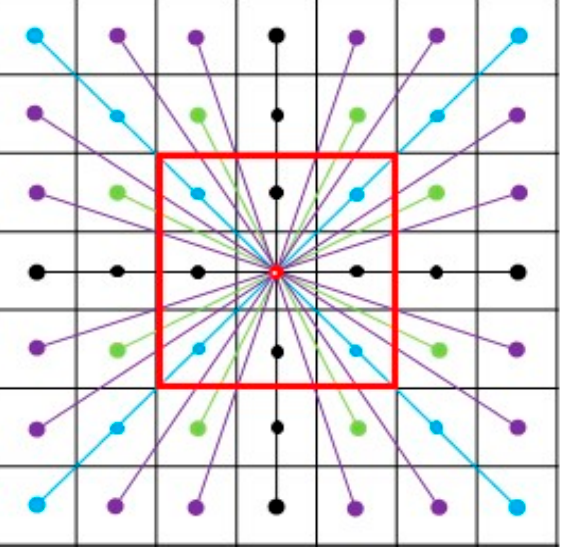
Figure 6. Diagram showing the 8-search-neighborhood and 48-search-neighborhood.